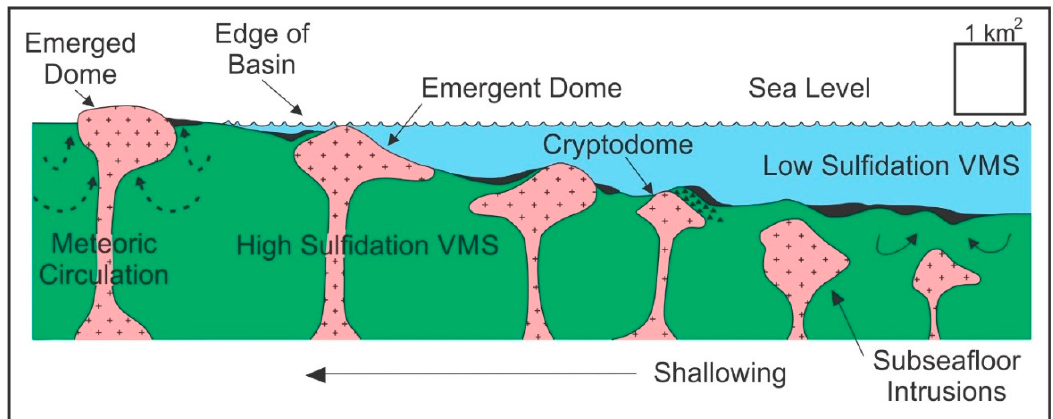
Figure 8. Schematic of volcanic rocks (green), subvolcanic intrusions (pink), and massive sulphides (black) of a VMS system evolving from seawater-dominated circulation cells in the sub-aqueous environment to the epithermal environment dominated by meteoric water circulation cells (dashed curves) overprinting the original VMS mineralization. Modified from Reference [18].